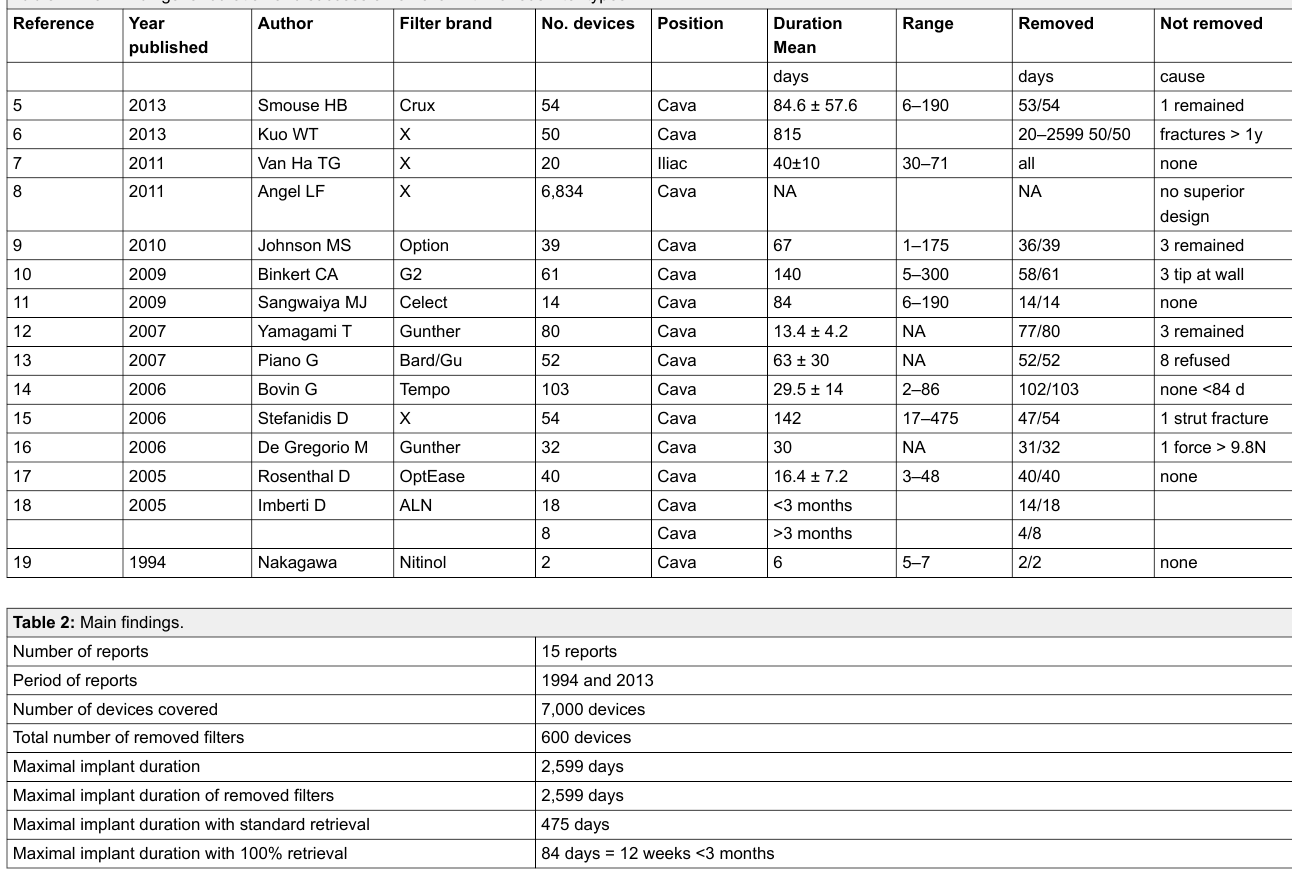
Table 1: Main findings for duration and success of removal with various filter types. Reference